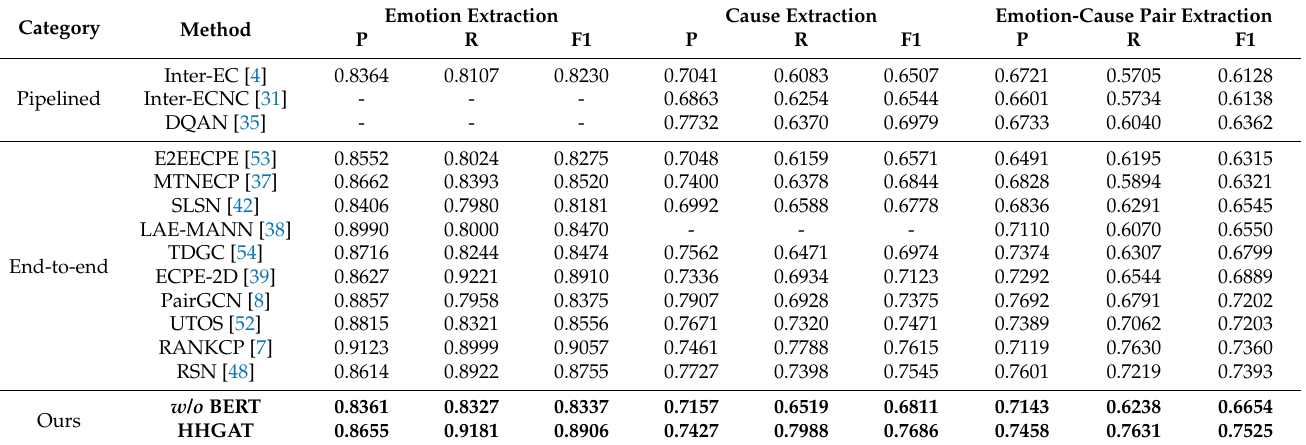
Table 1. Comparison of experimental results on the emotion extraction, cause extraction, and